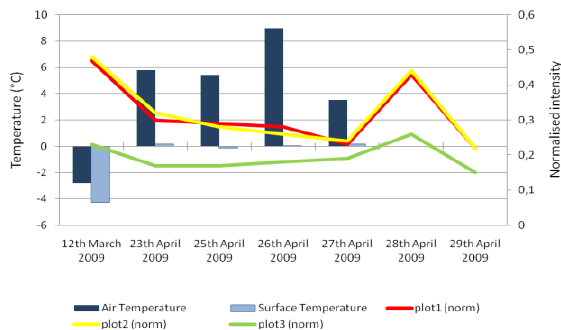
Figure 5. The air and surface temperatures and intensities of the 3 sample plots in Tähtelä in different days. For 28 th April and 29 th April approximate air temperatures were used. They had no connection to the backscattered